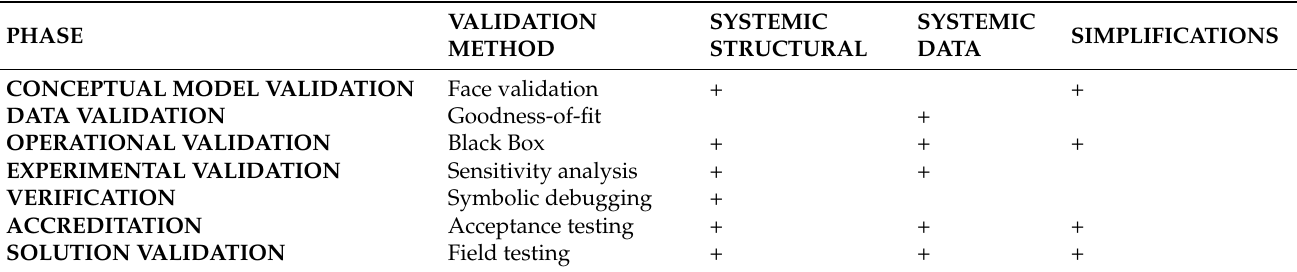
Table 6. Validations to be completed in the